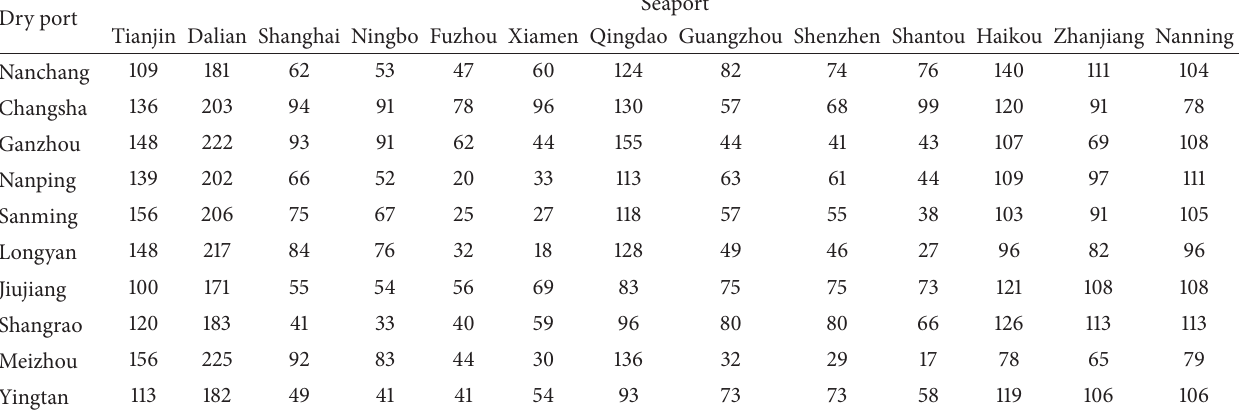
Table 7: Unit transport cost (in Yuan/ton) between alternative dry ports and various seaports.